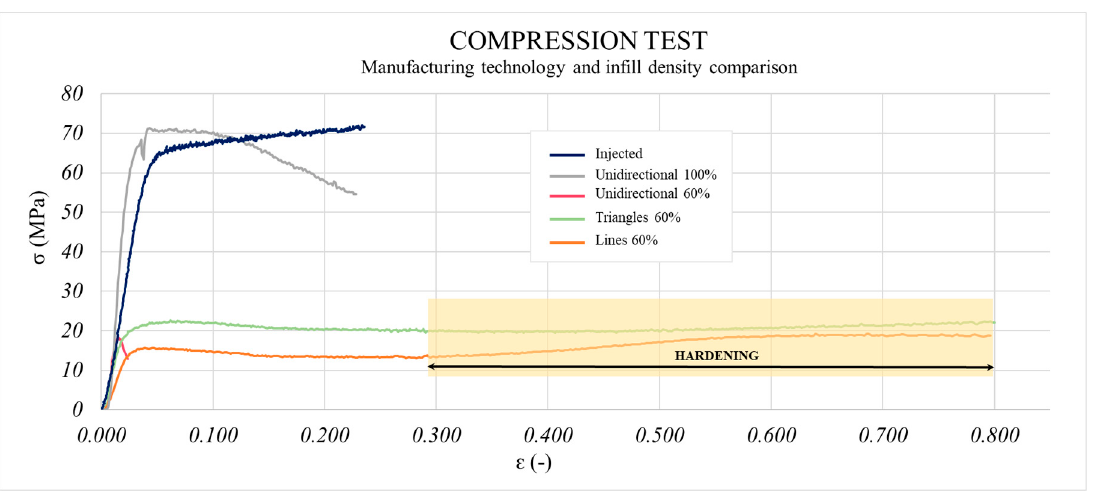
Figure 11. Compression test: influence of pattern on the behaviour of sample under compressive stresses. Figure11. Compressiontest: